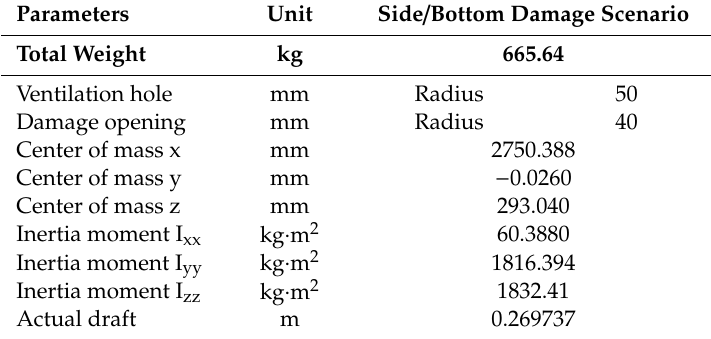
Figure 5. The schematic diagram of damage scenarios. Table 2. Characteristics of the hull and details of the damage opening and the ventilation hole.